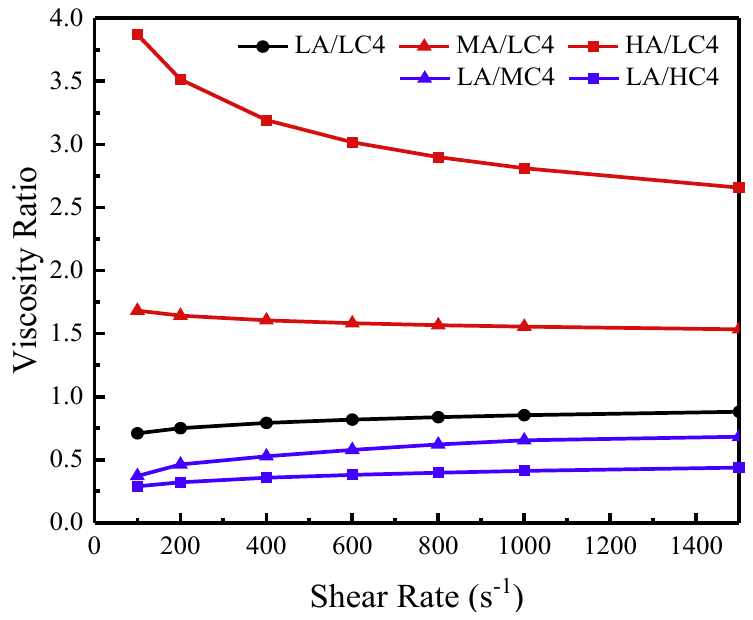
Figure 7. The melt viscosity of CDP and PA6 raw materials varies with the shear rate at 250 °C.